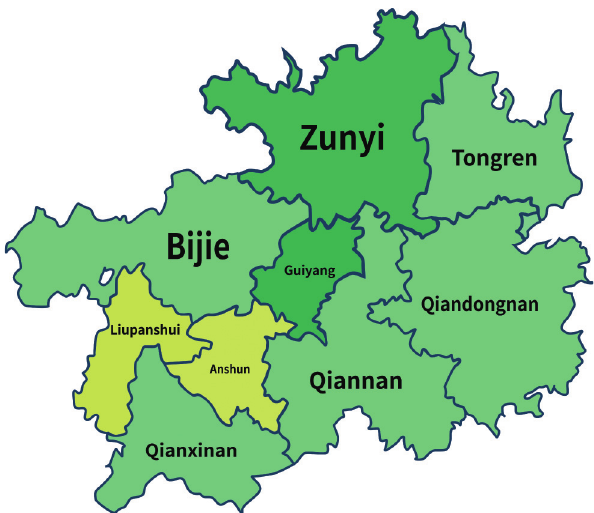
Figure 2: Ecological environment scores of different prefectures in Guizhou, 2018.